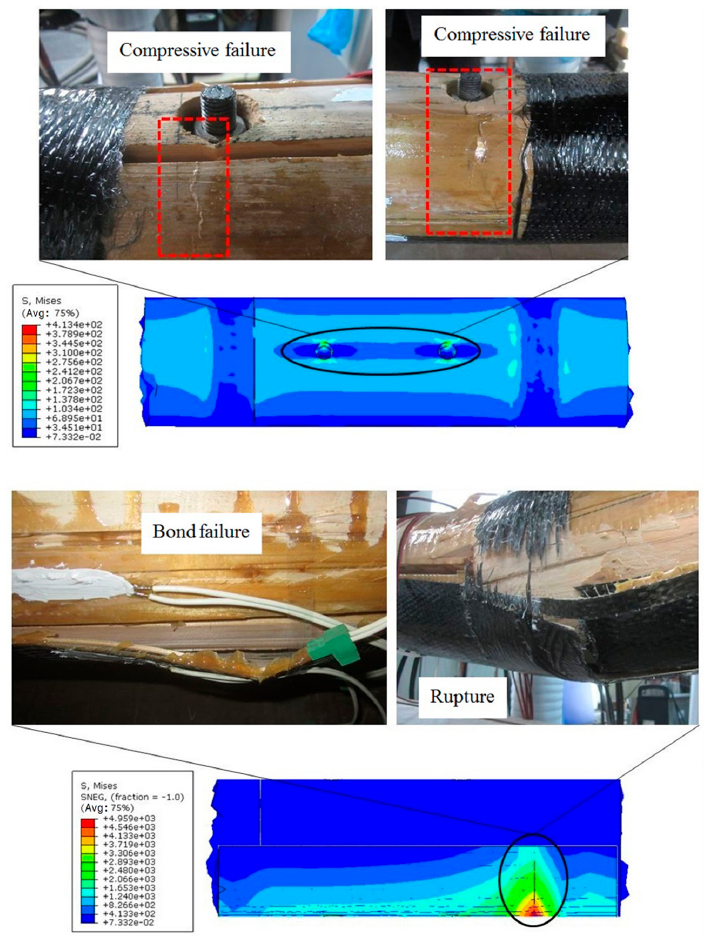
Figure 17. Comparison between the stress contour and the failure modes of the specimens.